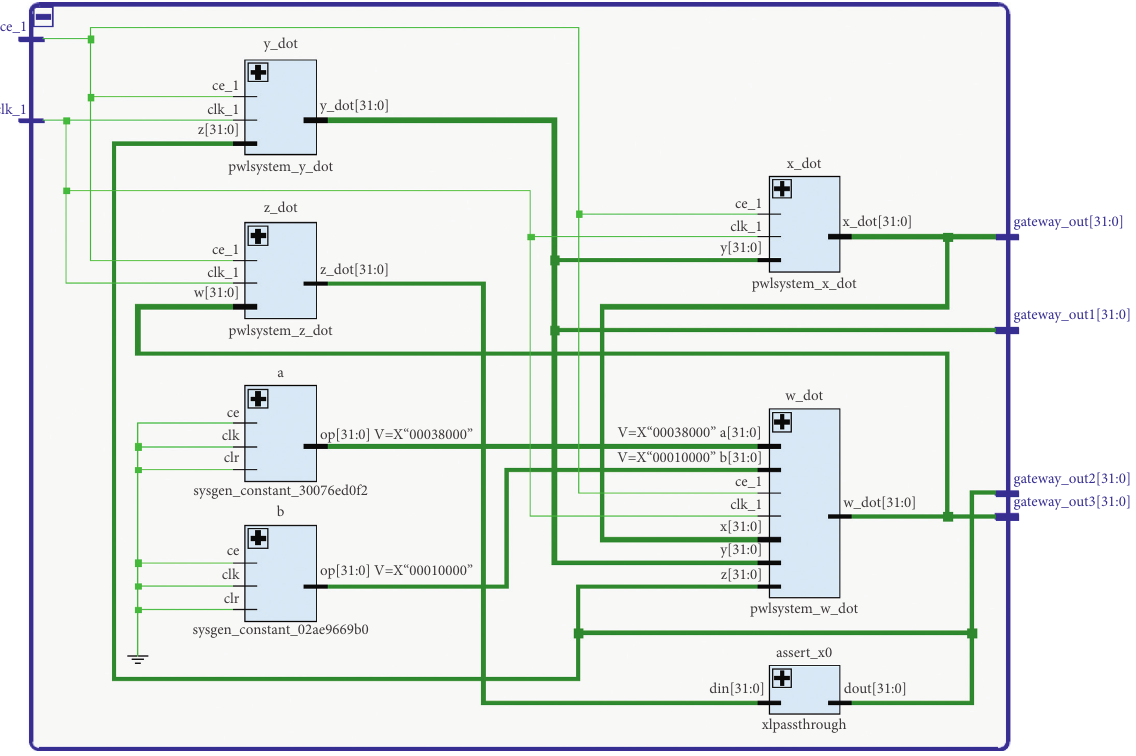
Figure 8: Register transfer level schematic of 4D PWL hyperjerk system implemented in Kintex 7 KC705.